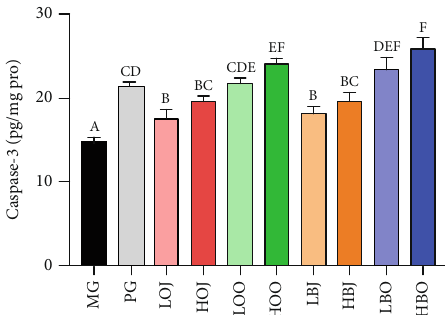
Figure 6: E ff ect of di ff erent treatments in the golden hamster on the activity of caspase-3. Values are expressed as the mean ± SD ( n = 8 ). Signi fi cance was de fi ned as P < 0 : 05